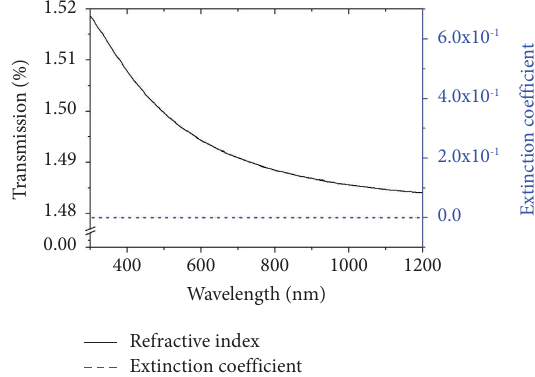
2 using the Cauchy equation [22].